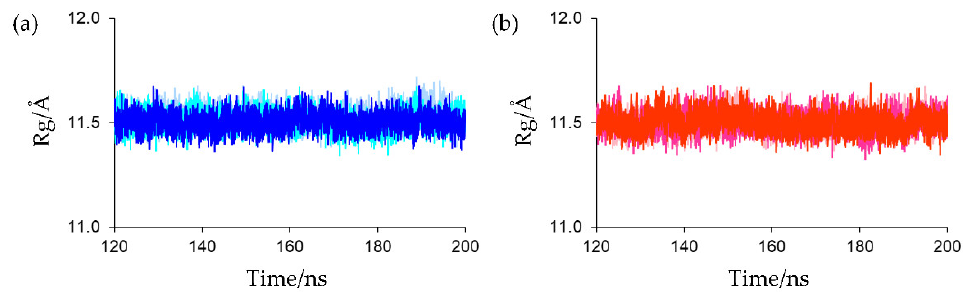
Figure 4. ( a ) Rg plots of protein backbone for oxidized Fd. Rg plots of the first, second, and third simulations were presented in light blue, cyan, and blue, respectively. ( b ) Rg plots of protein backbone for reduced Fd. Rg plots of the first, second, and third simulations were presented in light pink, magenta, and red, respectively.